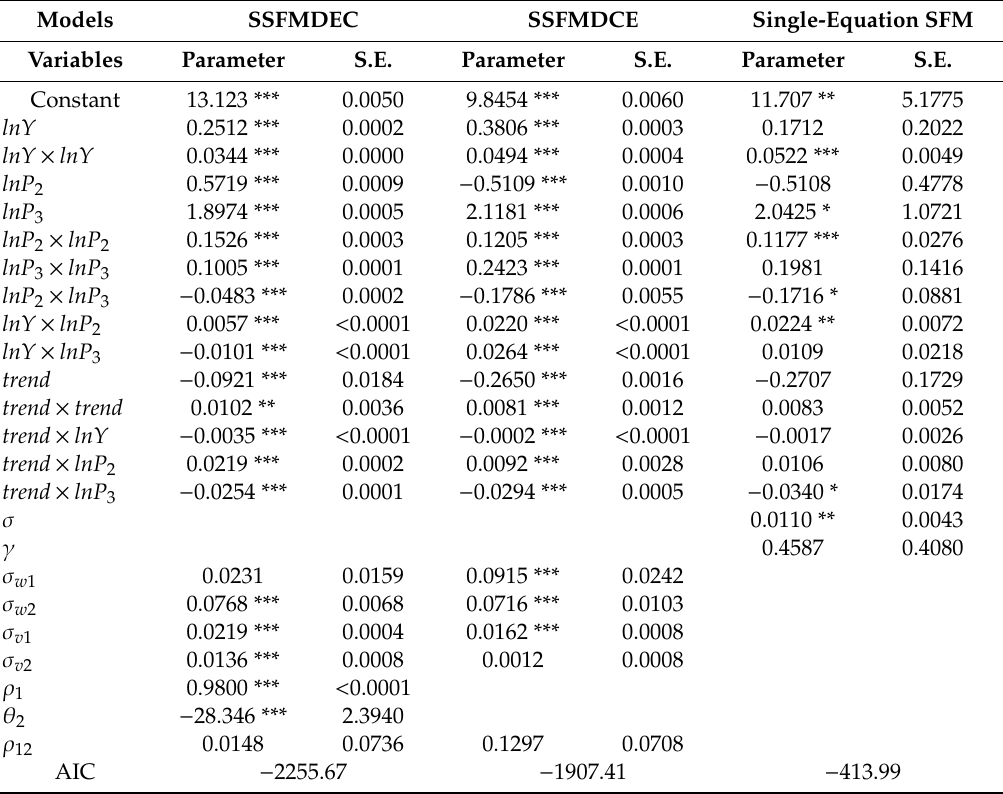
Table 4. Parameter estimation results of the cost